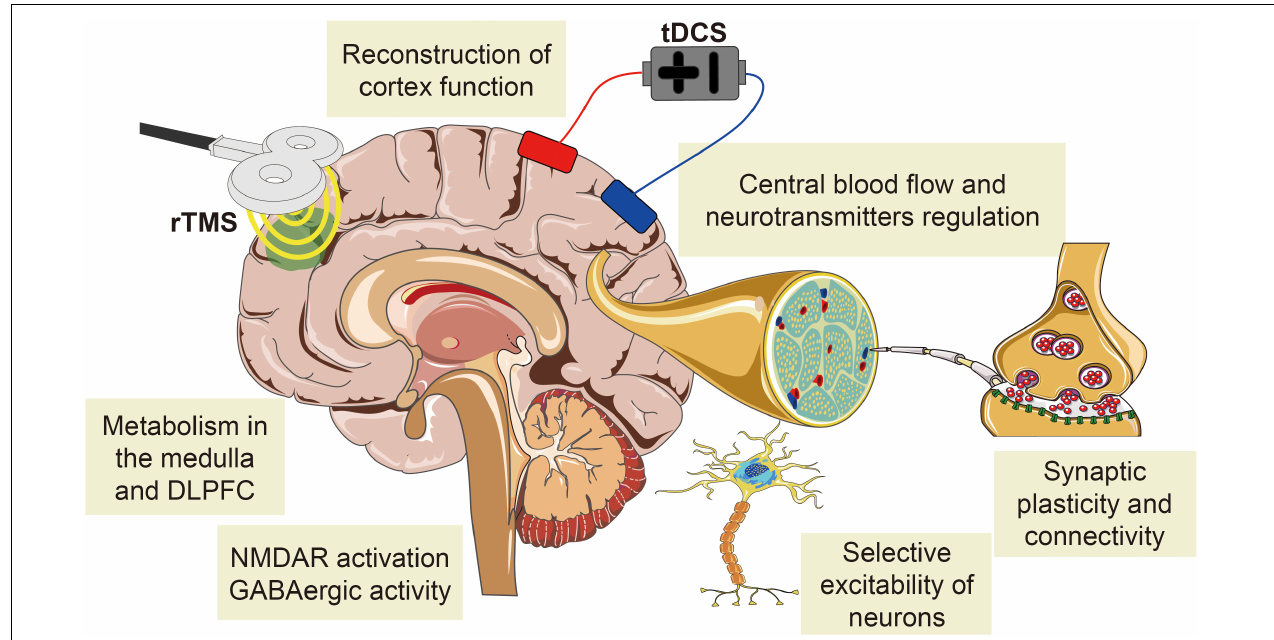
FIGURE 4 | The common mechanisms of NIBS analgesia on CNP. The analgesic mechanism of rTMS is similar to that of tDCS, both of which change cortical excitability and synaptic plasticity, regulate the release of related neurotransmitters, and affect the structural and functional connections of brain regions associated with pain processing and